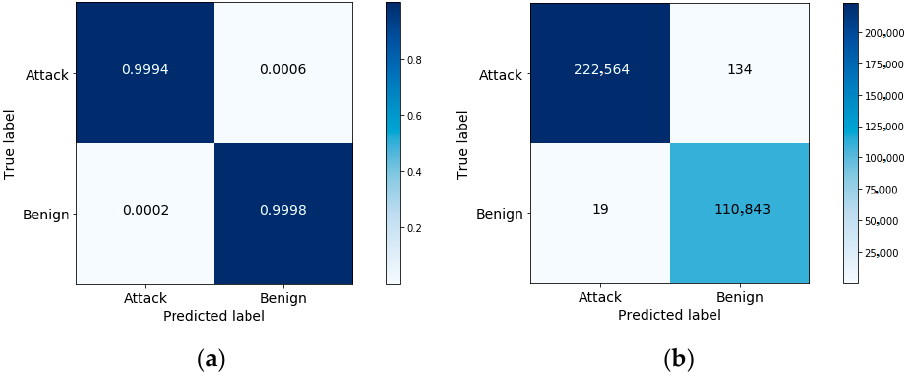
normalization. Figure 9. A confusion matrix for attack and benign classification: ( a ) with normalization;